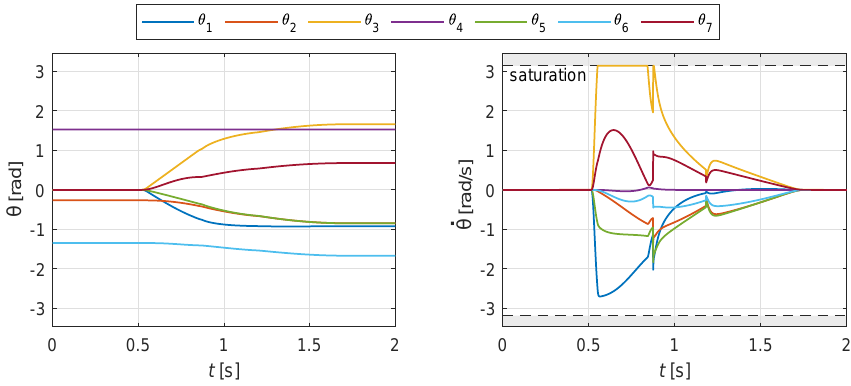
Figure 14. Example 2: joint rotations and speeds for the motion shown in Figure